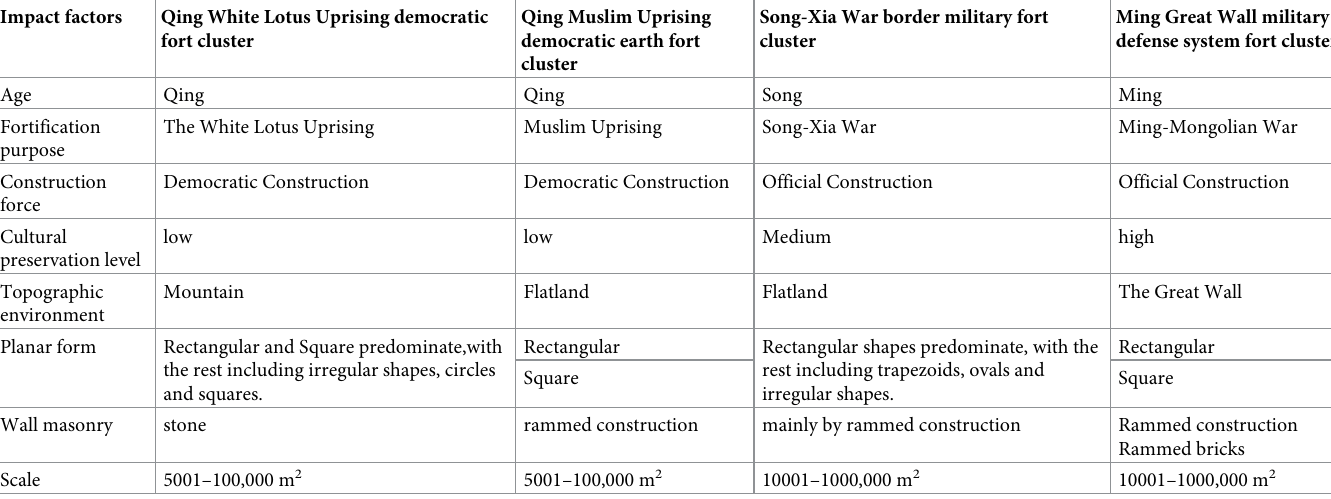
Table 3. Characteristics of cluster systems